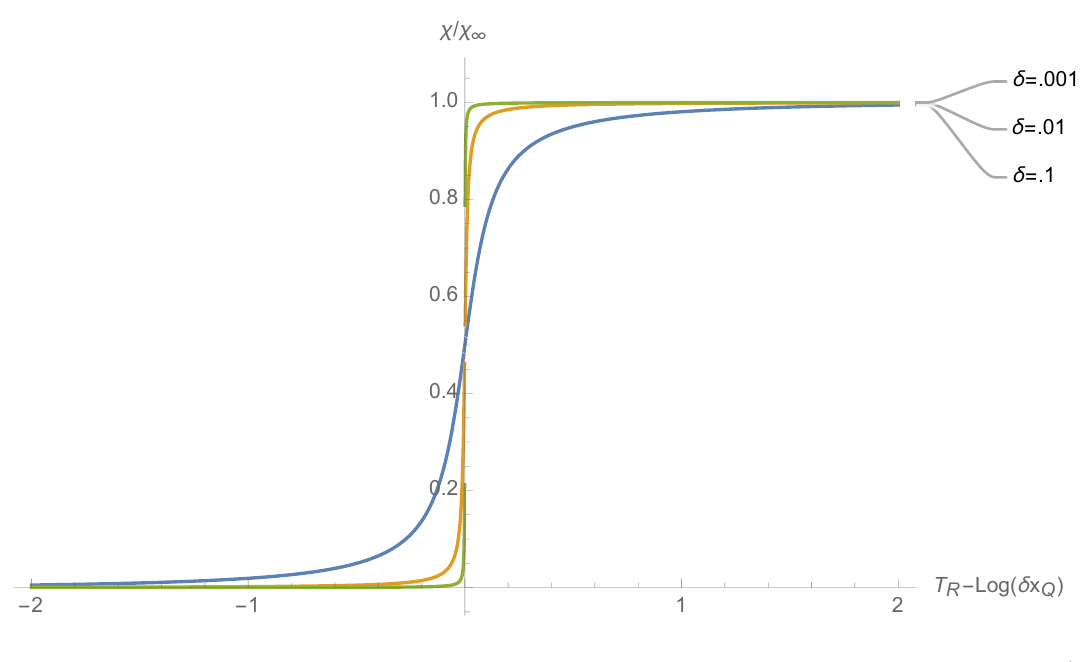
Figure 5 . We plot the fidelity susceptibility normalized by its value at T R = ∞ for J = 2 , ∆ φ = 1 / 2 and ∆ = 1 / 8 . Again, we have shifted the time axis so that the origin corresponds to e T R = δx O where δx is the null position of the QES, computed in (2.21). The dependence of the turnover Q time on the smearing scale, δ , has